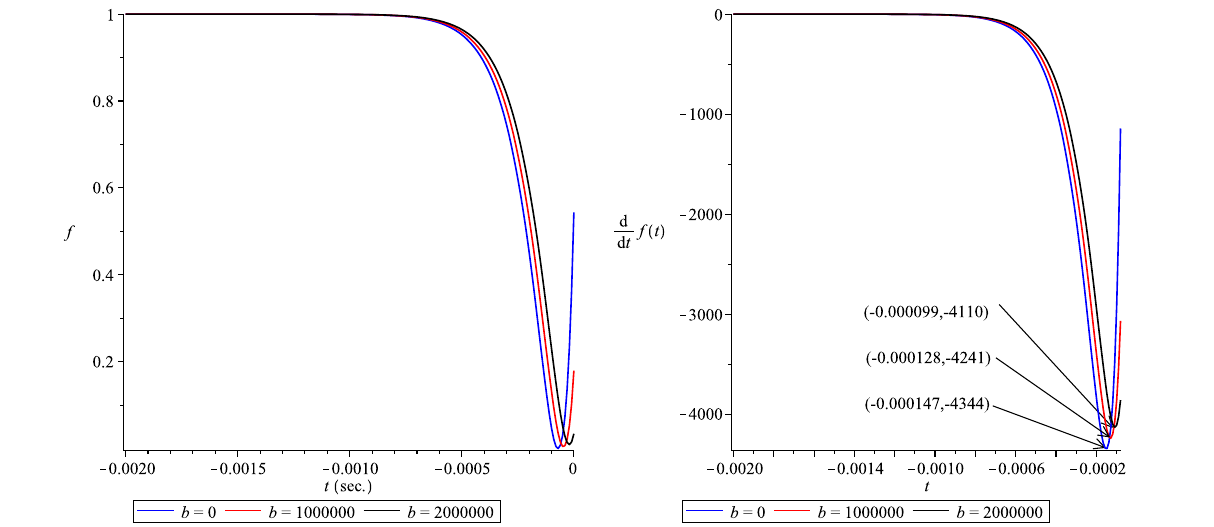
Fig. 1 (Left) plot of f ( t ) , the time component in the metric function X ( t , r ) , vs. t in second, for different charge/mass ratios represented by b . The decrease in f ( t ) delays as the charge/mass ratios increases.